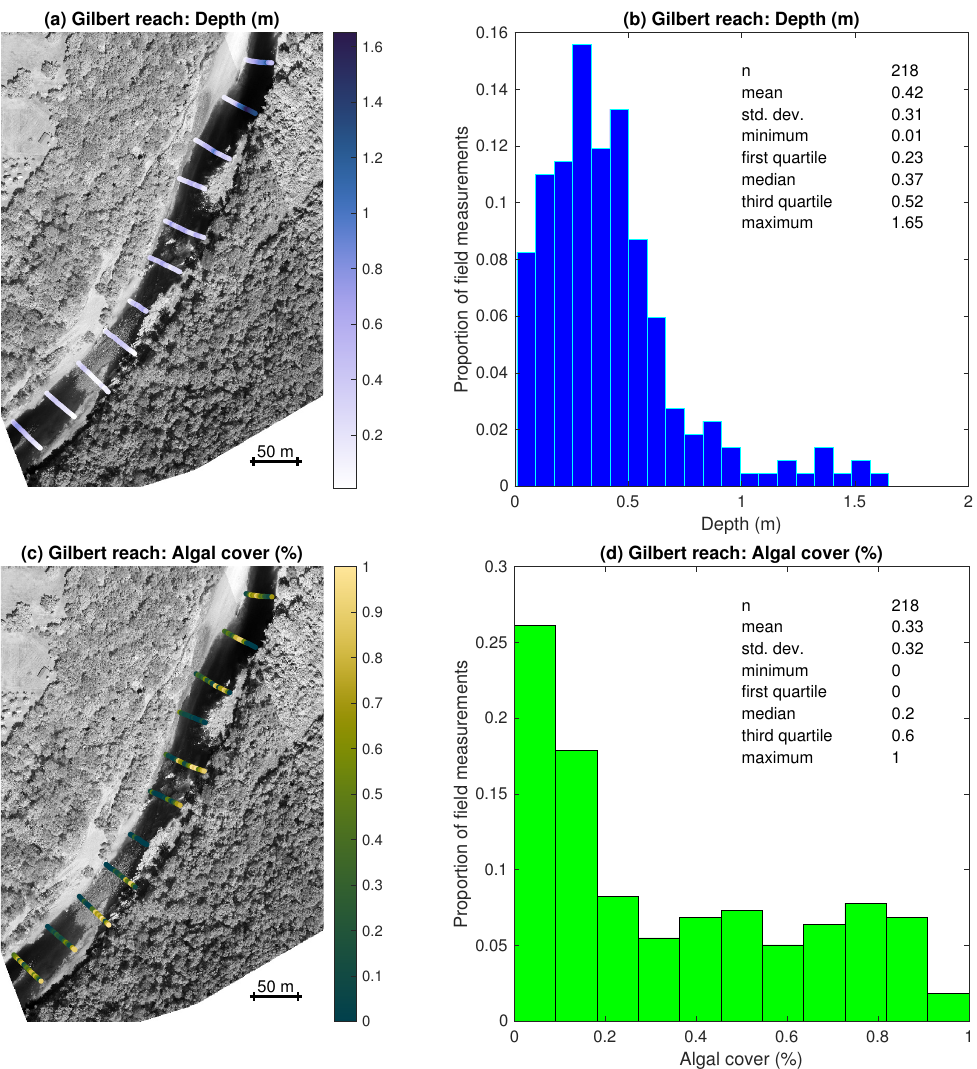
Figure 5. Field observations from the Gilbert reach of the Buffalo River. Measurements of water depth are summarized in a ( a ) map and ( b ) histogram. Similarly, the data on percent cover of benthic algae are presented in ( c , d ). The background image is an orthophoto produced from the airborne data collected the same day as the field measurements. Flow direction is from the bottom toward the top of the